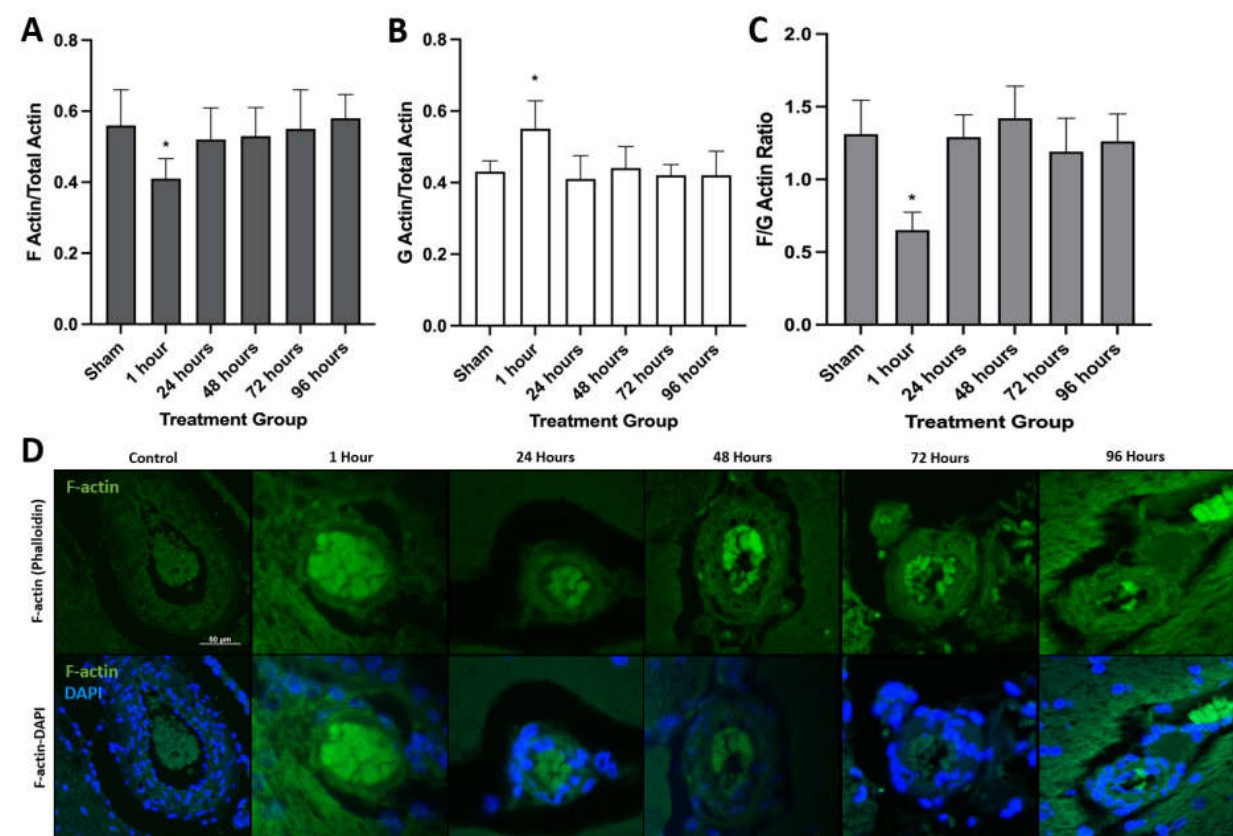
Figure 1. F-actin ( A ) and G-actin ( B ) to total actin ratios demonstrating decreased concentrations of F-actin and increased concentrations of G-actin relative to all other treatment groups. Likewise, the F:G-actin ratio was significantly decreased (* p < 0.05) at 1 h post-H-FIRE treatment compared to sham controls ( C ). F-actin (Phalloidin) fluorescence in treated rat brains revealed a decrease in F-actin reactivity with peripheral redistribution at 1 h post-H-FIRE treatment relative to all other treatment groups. All images were captured at 200× magnification ( D ). The scale 50µm is consistent across all images.